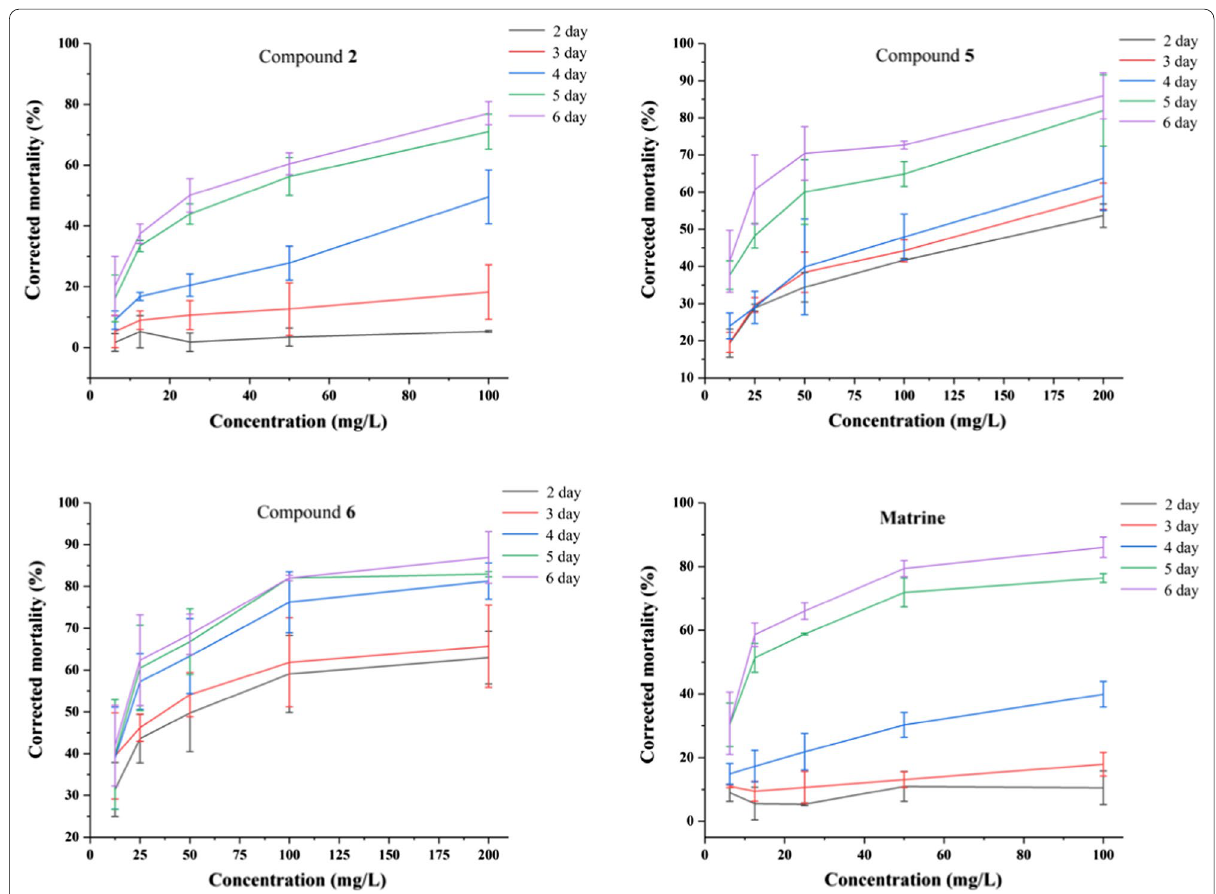
Fig. 4 Toxic activity anainst D. citri of compounds 2 , 5 , 6 and matrine